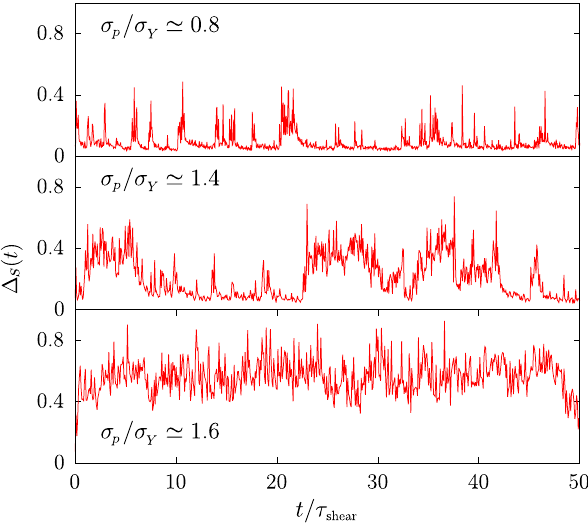
FIG. 4. Time sequence for the supremum of droplet displace- ð t Þ [see Eq. (5)] at the same peak stresses displayed in ments Δ s Fig. 3 for the Kolmogorov flow. Time is rescaled by the stress- ¼ S − 1 as derived from Eq. (3). At the dependent shear time τ shear smallest forcing σ p = σ Y ≃ 0 . 8 , Δ shows only a few intermittent s spikes with the smallest absolute values. For a peak stress σ = σ ≃ 1 . 4 , passing from one rheological branch to the other p Y (see Fig. 2), Δ displays both small and large stable values, whereas s = σ ≃ 1 . 6 , there are fluctuations around a large mean value. at σ p Y